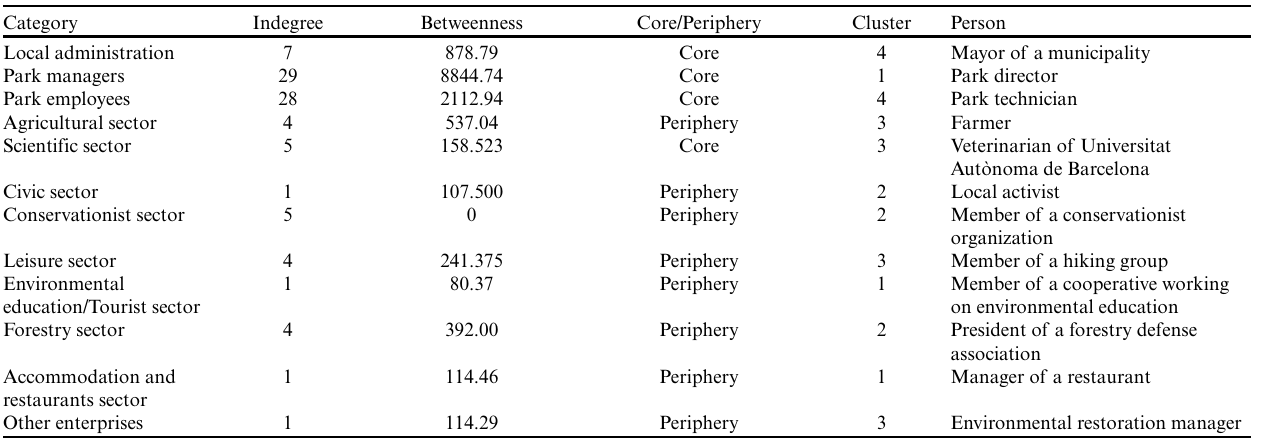
Table 4 . Stakeholders selected for future participatory